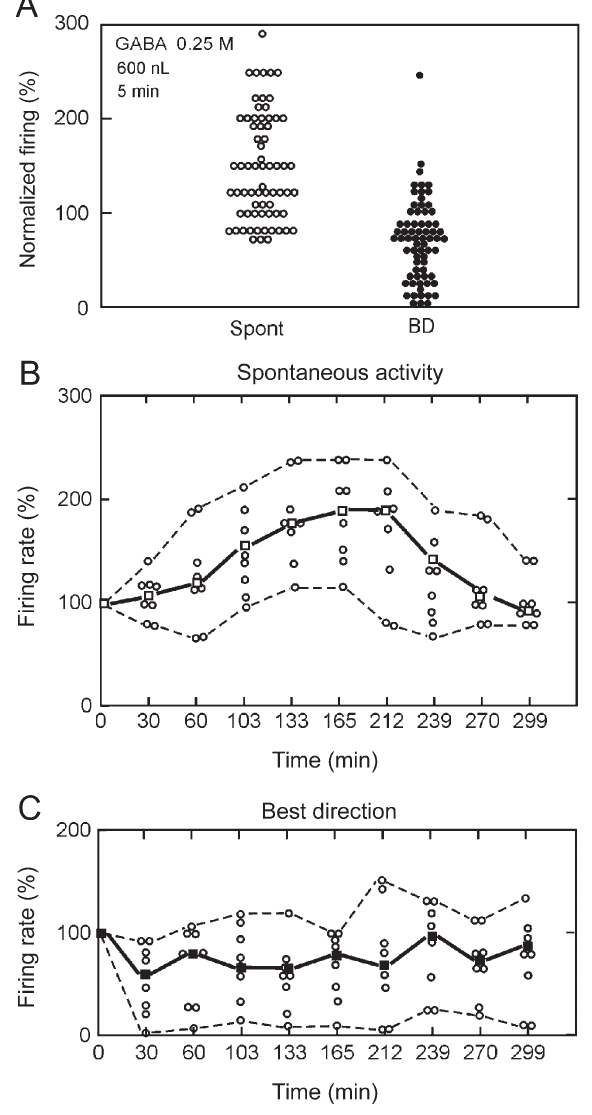
Figure 3. A , Strength and time course of the effect of a medium size GABA injection (600 nL, 0.25 M) on B , spontaneous activity (Spont) and C , best direction (BD) of 8 neurons recorded in V2. The relative firing rate of the cells is plotted over a period of 300 min (9 repeated measurements). Open circles are normalized percentage of firing rate of the spontaneous activity ( B ) and of the best response ( C ) of each of the six neurons. Squares are the mean of normalized firing rate of the spontaneous activity ( B ) and the response to the best direction ( C